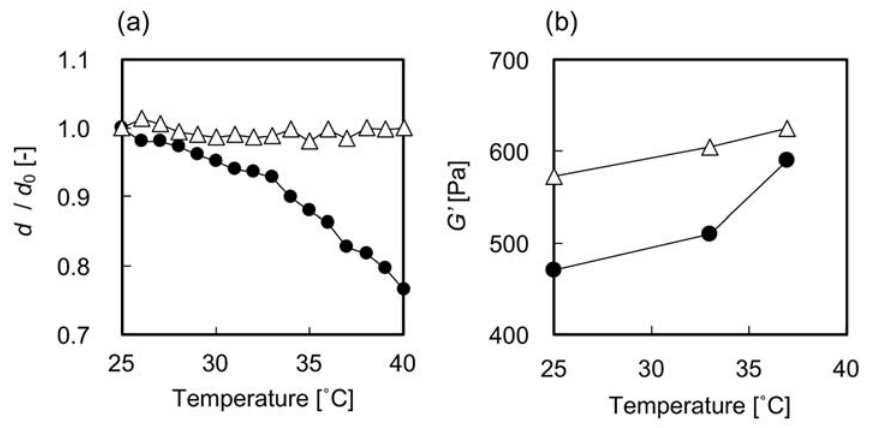
Figure 1. ( a ) The swelling ratio and ( b ) G’ of gels relative to temperature change. Symbols: closed circles, PNIPAAm gel; open triangles, PDMAAm gel.